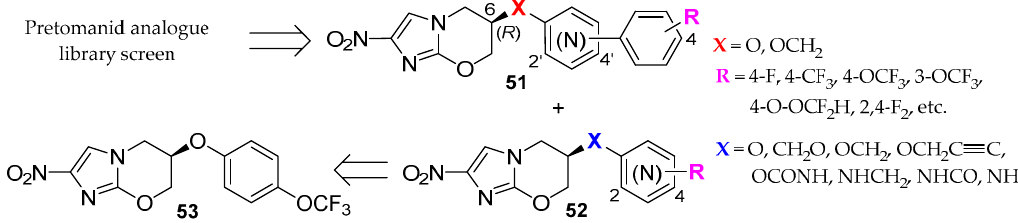
Figure 12. Genus of synthesized compounds ( 51 – 53 ) to treat visceral leishmaniasis.